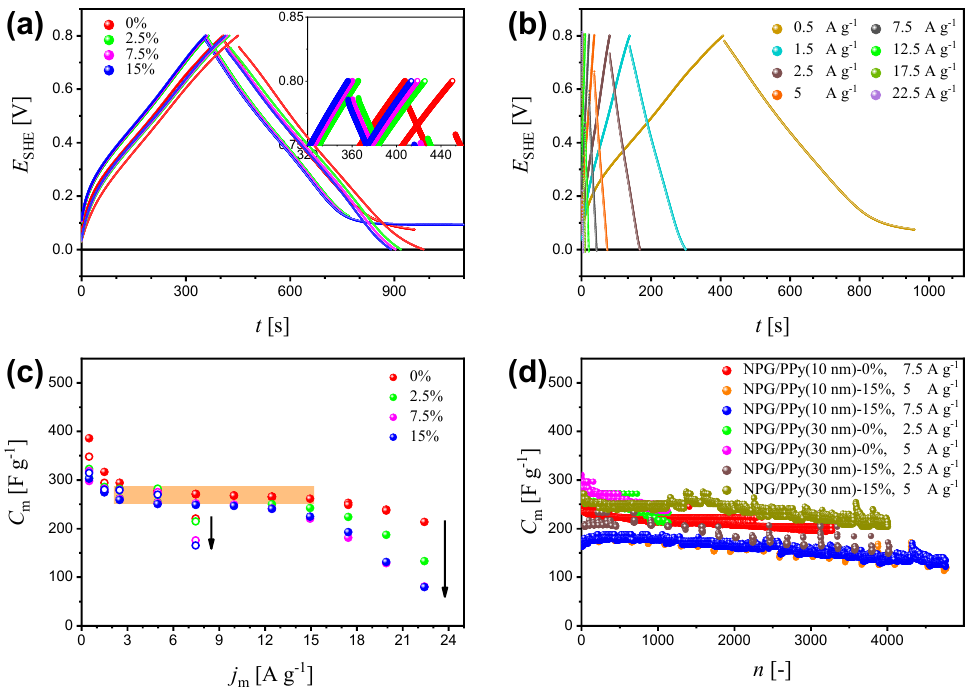
Figure 3. ( a ) Galvanostatic charge-discharge (GCD) curves of NPG/PPy(10 nm) and NPG/PPy(30 nm) at a current density of j m = 0.5 A g − 1 under various deformations. Closed and open symbols represent NPG/PPy(10 nm) and NPG/PPy(30 nm), respectively. The colors indicate the deformation; the inset at a higher magnification distinguish the curves. ( b ) GCD curves of NPG/PPy(10 nm) at j m = 0.5 ∼ 22.5 A g − 1 under zero deformation. ( c ) Specific capacitance, C m , as a function of j m based on the GCD results of NPG/PPy(10 nm) and NPG/PPy(30 nm). Symbol and color conventions follows those in ( a ). ( d ) Cycling performance of NPG/PPy(10 nm) and NPG/PPy(30 nm) under deformations of 0% and15%. The current densities are labeled in the figure.